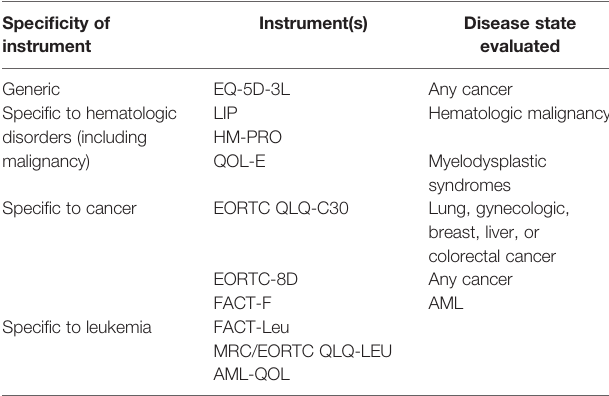
TABLE 2 | Comparison of instrument speci fi city and disease states in which the instruments were